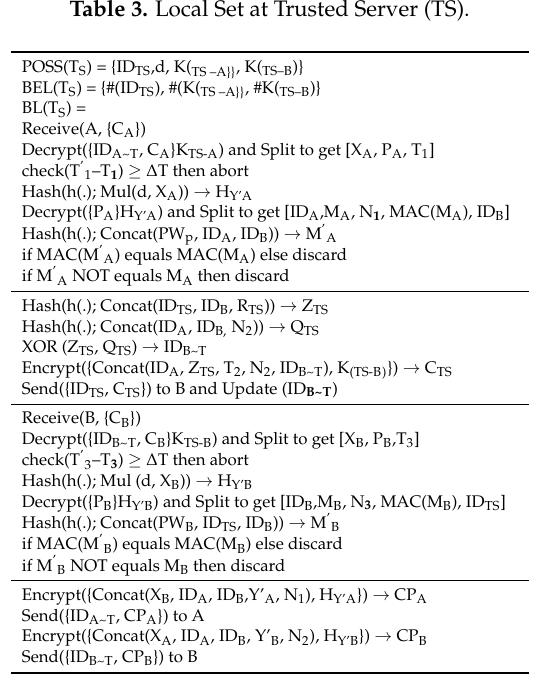
Table 3. Local Set at Trusted Server